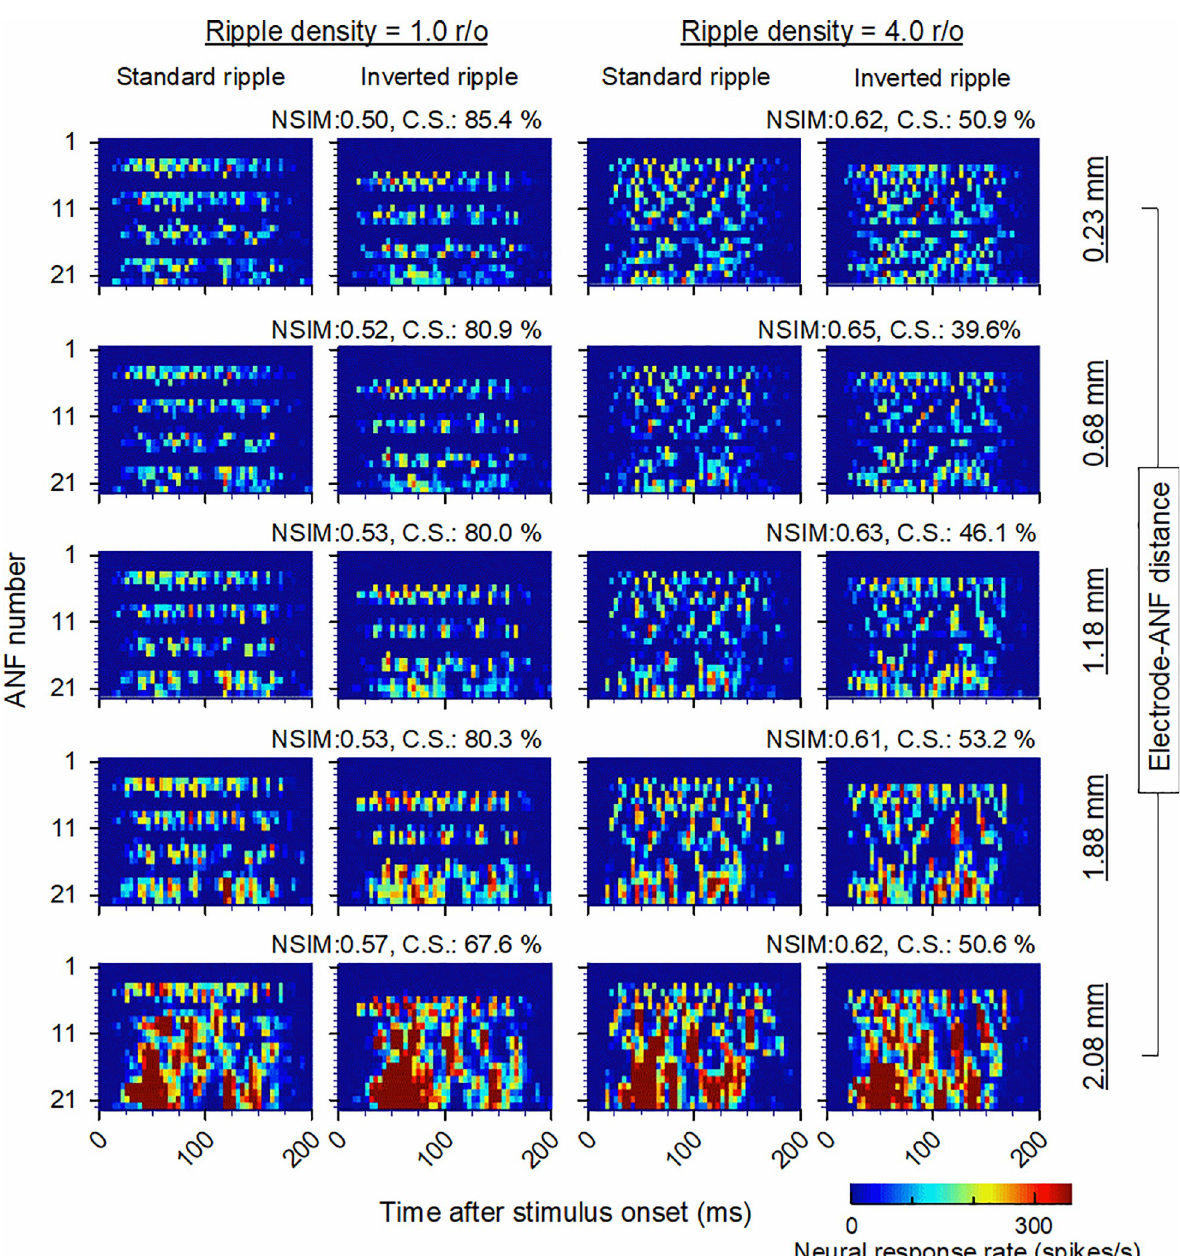
Fig 8. Example neurograms for ripple densities of 1.0 (columns 1 and 2) and 4.0 r/o (columns 3 and 4) and five electrode–ANF distances of 0.23, 0.68, 1.18, 1.88, and 2.08 mm (top to bottom). The indicated NSIMs and correct scores (C.S.) were computed using the neurograms for the standard and inverted ripple